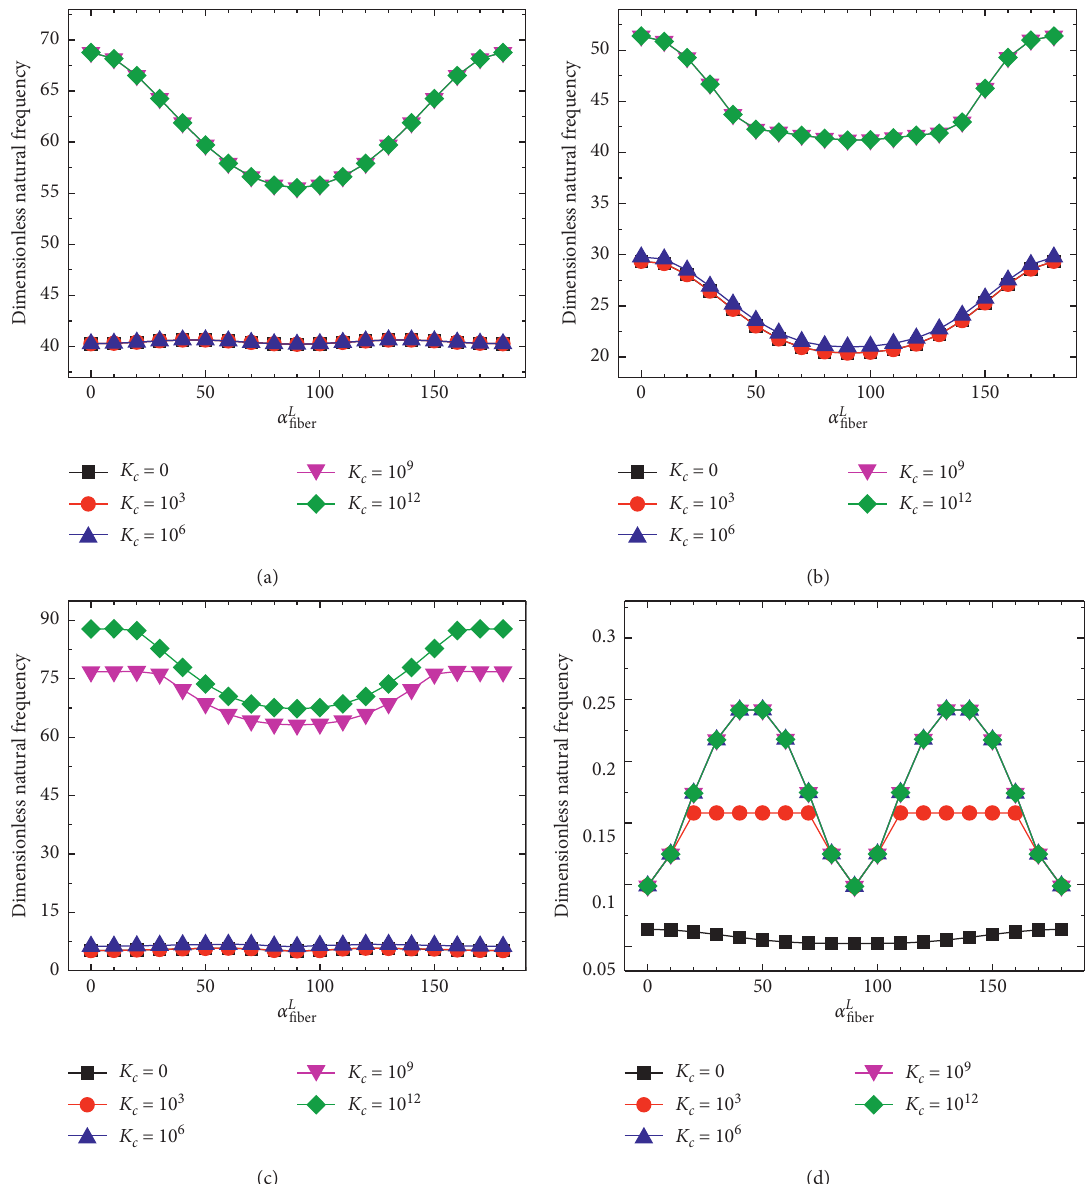
Figure 7: Variation of dimensionless natural frequency versus fiber angle for an LCDPS with different boundary conditions. (a) FCFC- FCFC, 5th mode; (b) FFCC-FFCC, 6 th mode; (c) FCCC-FCCC, 7th mode; (d) FFFF-FFFF, 8th